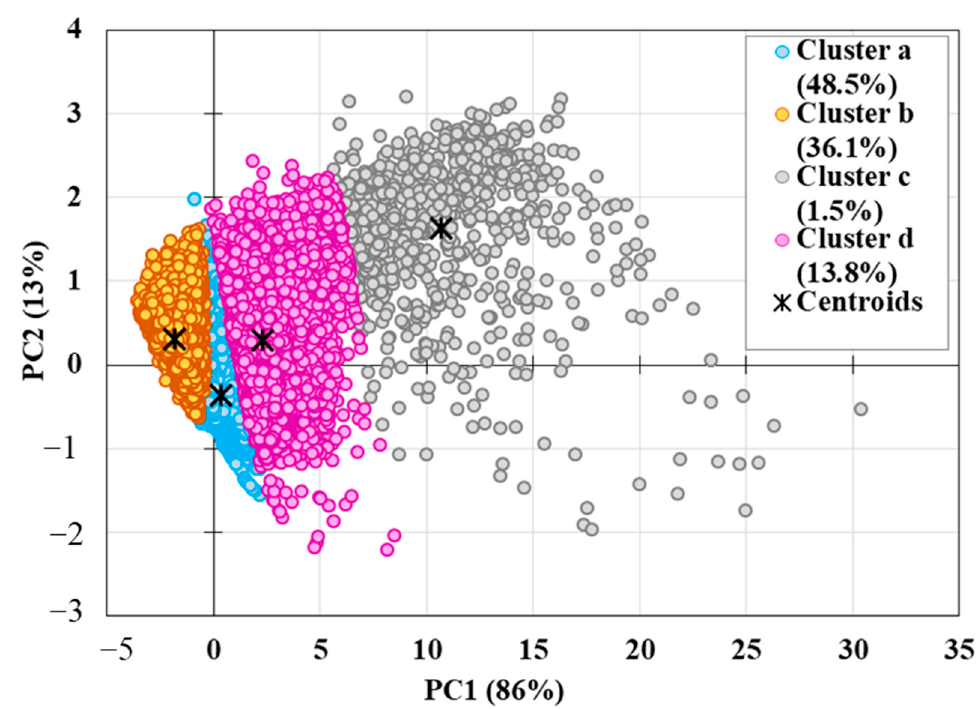
Figure 6. The clustering scatters of the spectra and the values of PC1 and PC2.